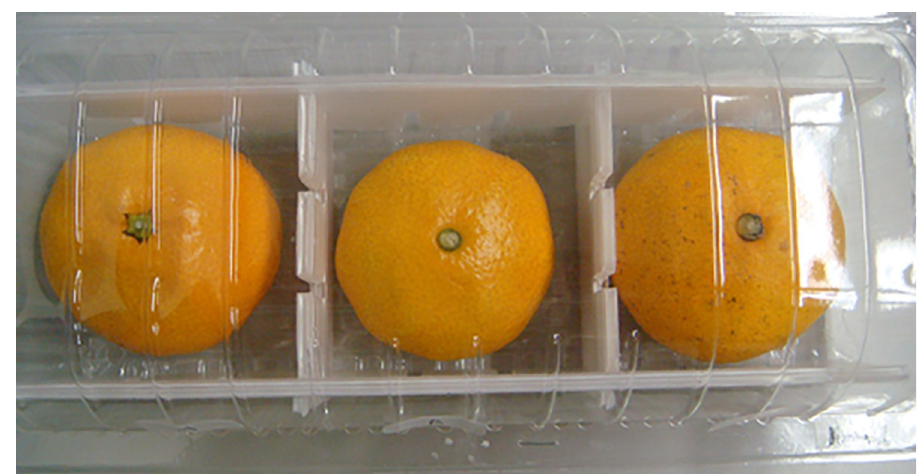
Fig 1. A picture of the oranges used in three treatments as the HLS, the HOS, and the HOSCT.